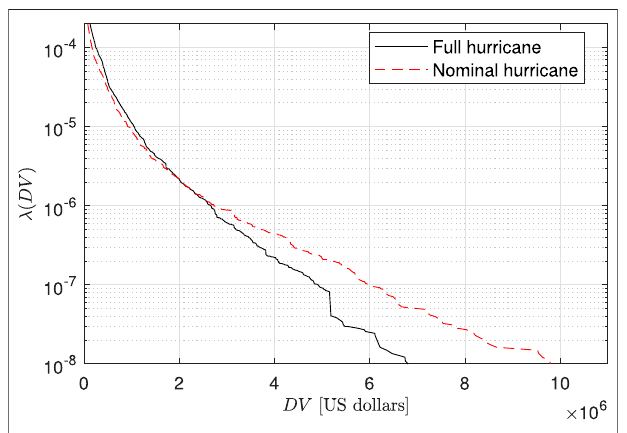
FIGURE 11 | Repair cost loss curves in United States dollars for the nominal and full hurricanes.